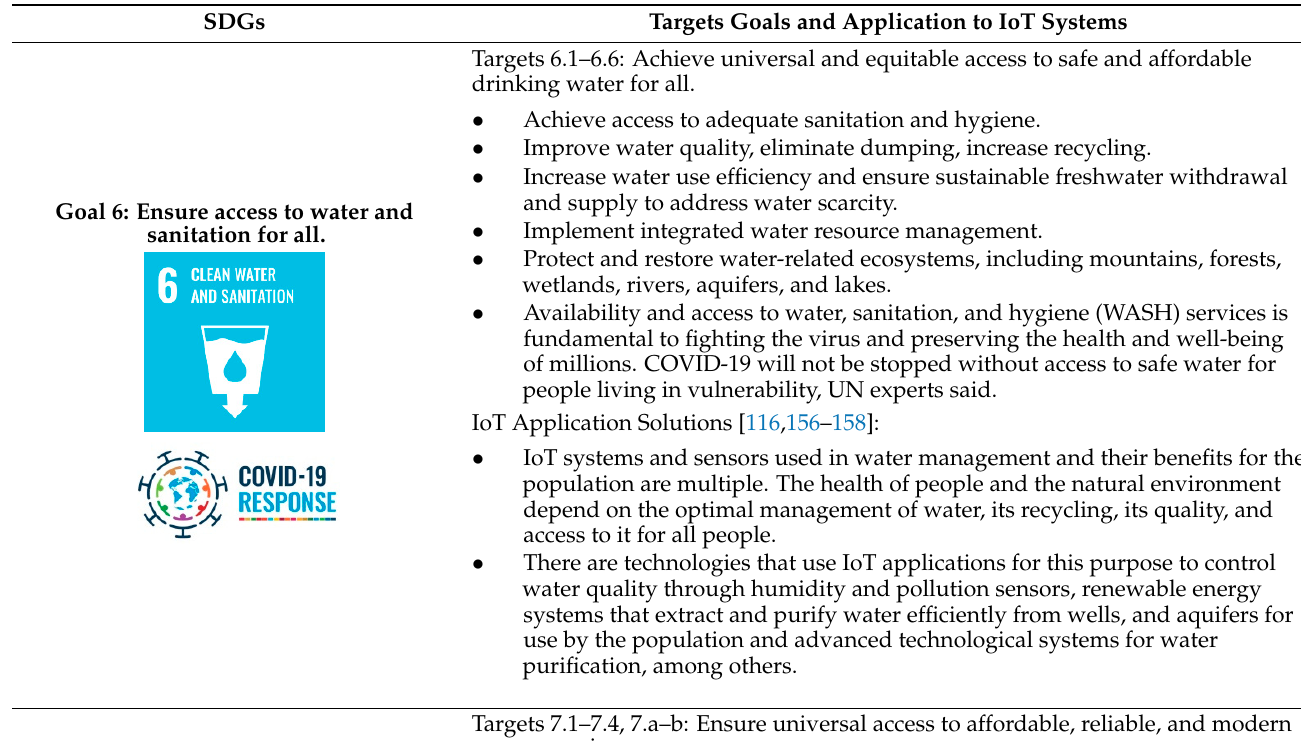
Goal 1: End poverty in all